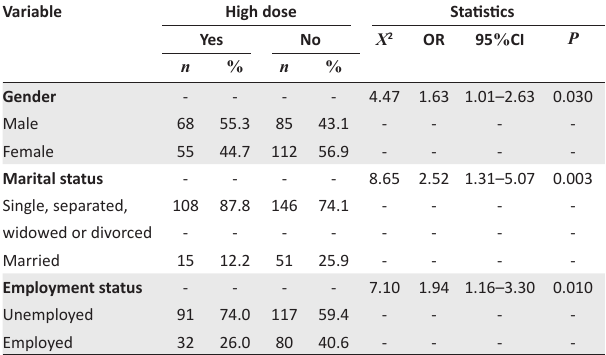
TABLE 2: Comparison of sociodemographic characteristics of participants and high dose prescribing.